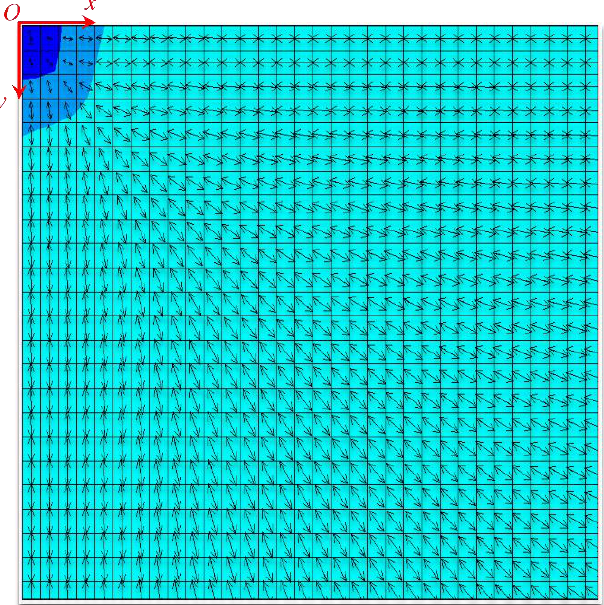
Figure 4. First principal stress direction of the film when the loading ratio was y : x = 1.